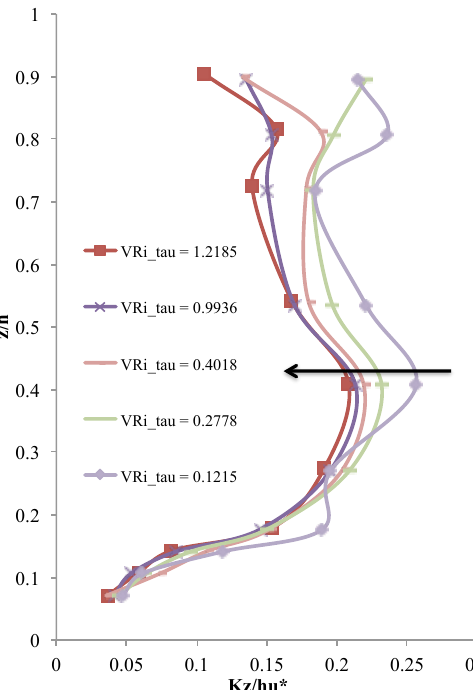
Figure 10. Vertical sediment diffusivity was calculated using sed- iment concentration profiles from experiments performed by Cole- man (1986). With an increase in ˜ V Ri τ (cases 1–5), the vertical sed- iment diffusivity in the open-channel flow